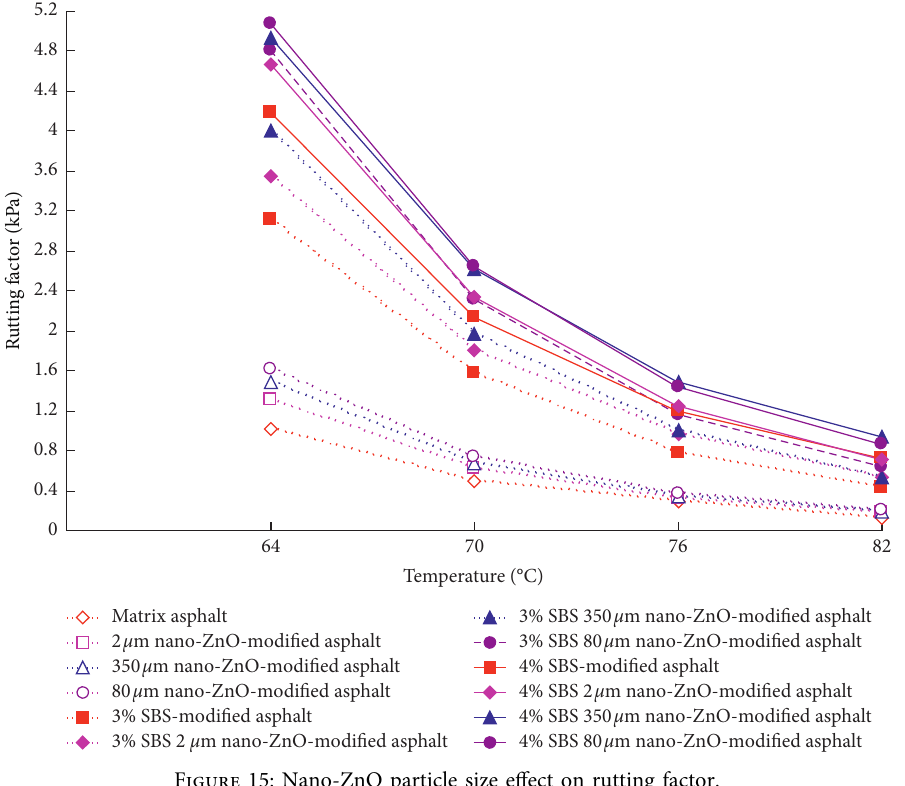
Figure 15: Nano-ZnO particle size effect on rutting factor.